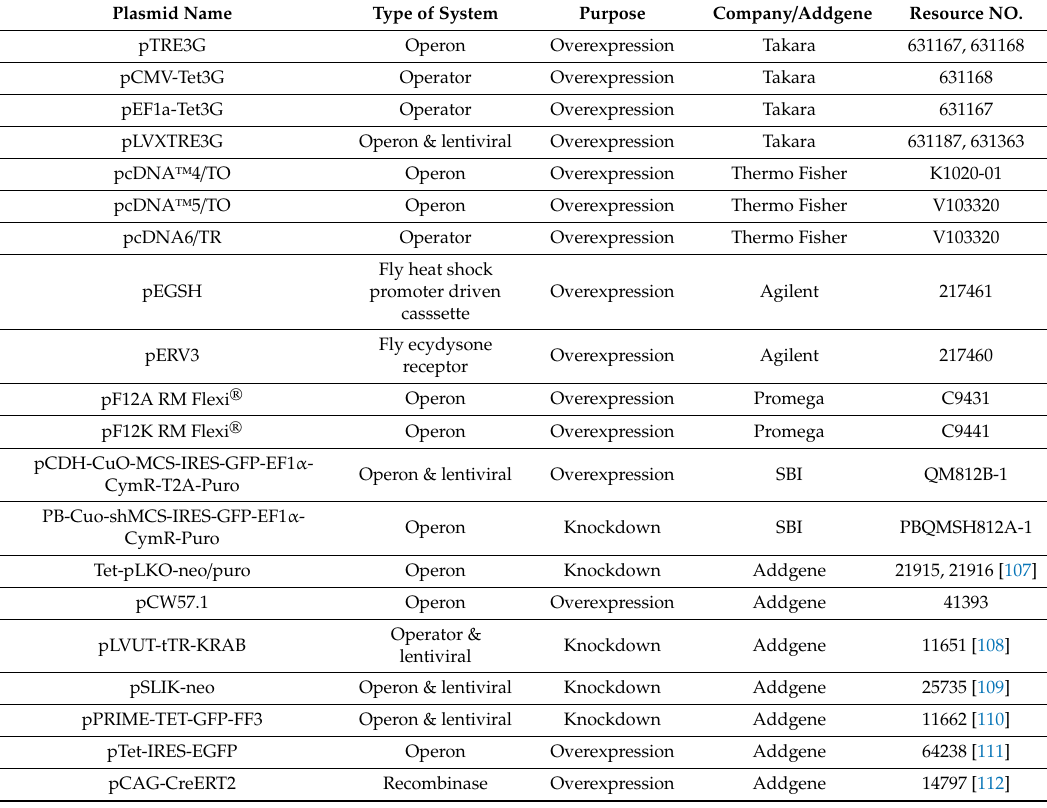
Table 3. Commercially available and Addgene-stored plasmids (those with modified tags are not